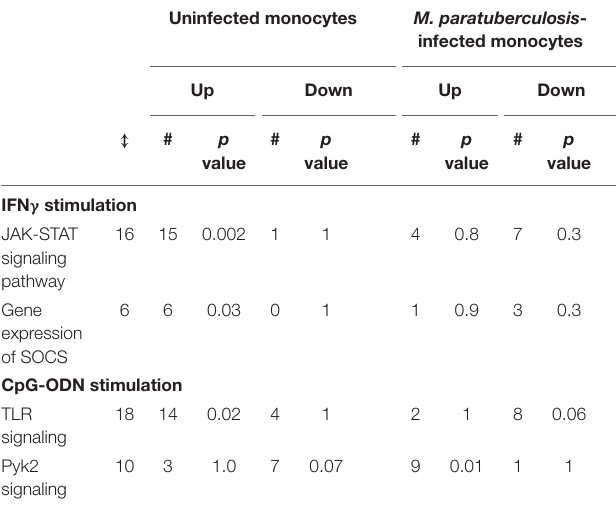
TABLE 2 | Bovine monocytes differentially respond to IFN γ and CpG-ODN depending on M. avium subsp. paratuberculosis infection status. Uninfected